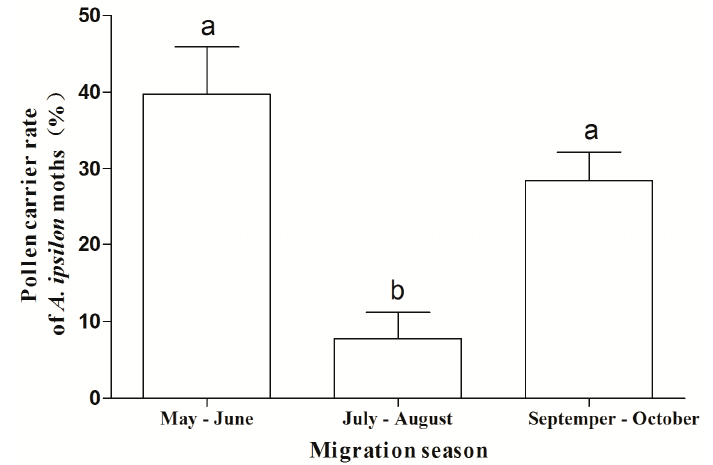
Figure 3. Frequencies of pollen deposition on migratory A. ipsilon near the Bohai Sea area in different migration stages during 2012–2014. Bars sharing the same letter mean there were no significant differences at the 5% level by Tukey’s honestly significant difference (HSD) tests.